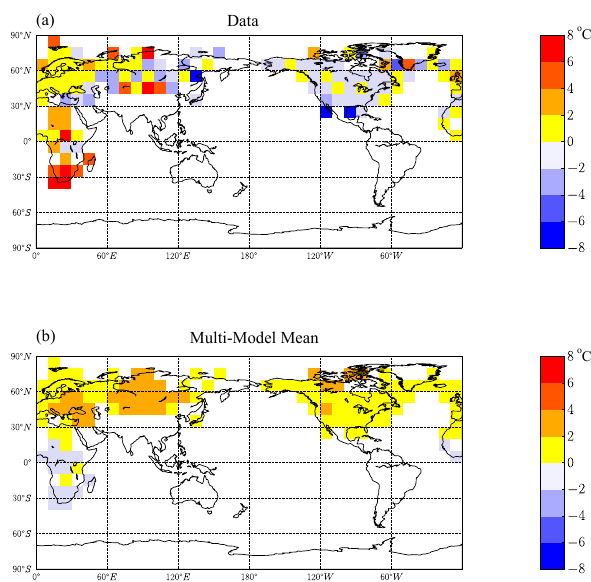
Fig. 8. The hottest month MH anomaly rebinned onto a 10 degree grid, to more clearly illustrate the model-data mismatch on the sub- continental